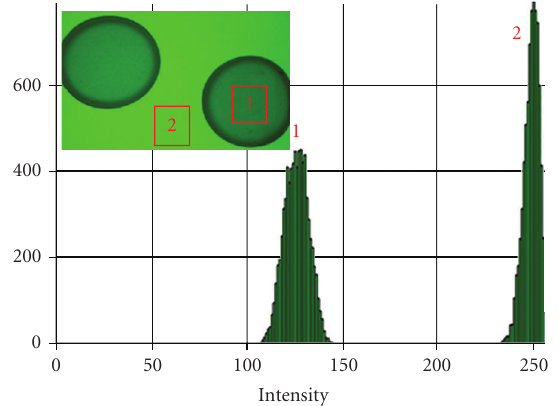
Figure 9: Visualization of FITC-dextran permeation into micro- capsules by CLSM. a Molecular weight of FITC-dextran; b Type of microcapsules. Bars = 200 μ m